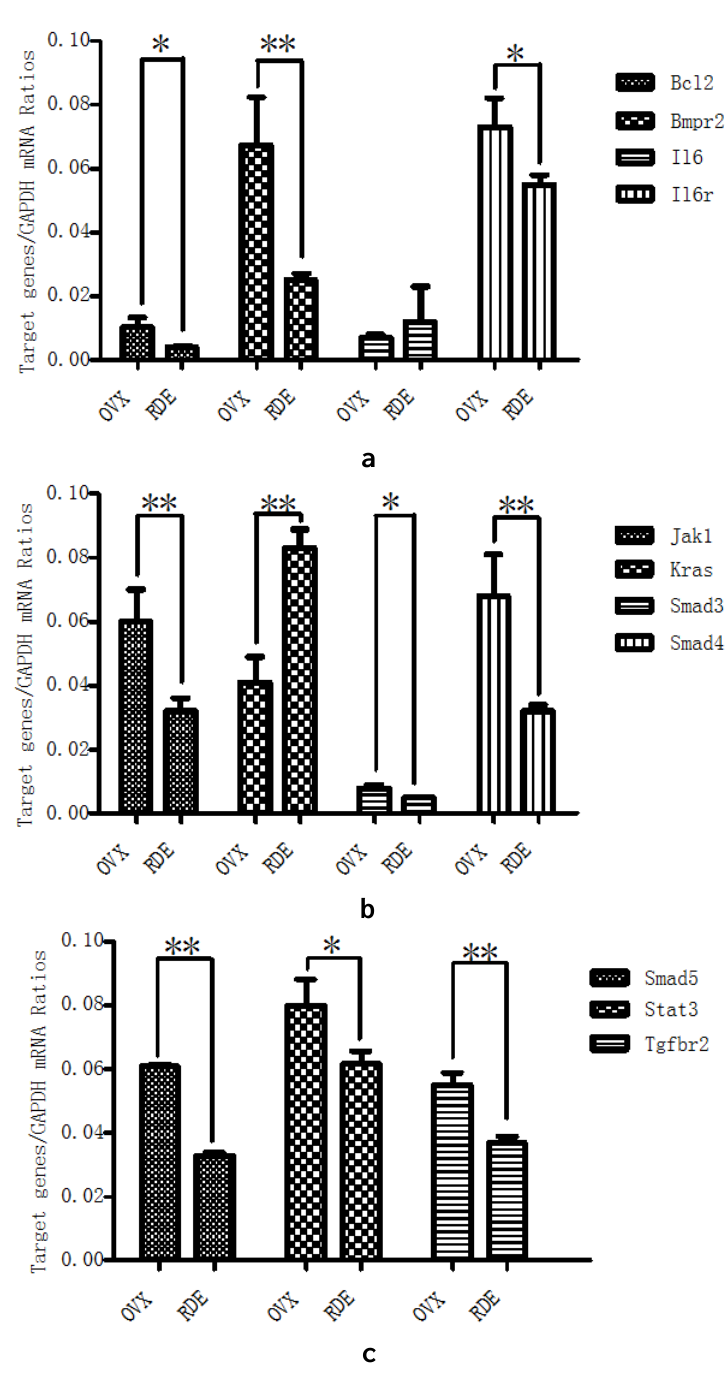
Figure 6. Validation of 11 target genes by qRT-PCR: Effect of RDE on the expressions of Bmpr2 , Il6, Il6r , and Bcl2 ( a ); Jak1 , Kras , Smad3 , and Smad4 ( b ); and Smad5 , STAT3 , and Tgfbr2 ( c ). * P < 0.05; ** P < 0.01, vs . OVX